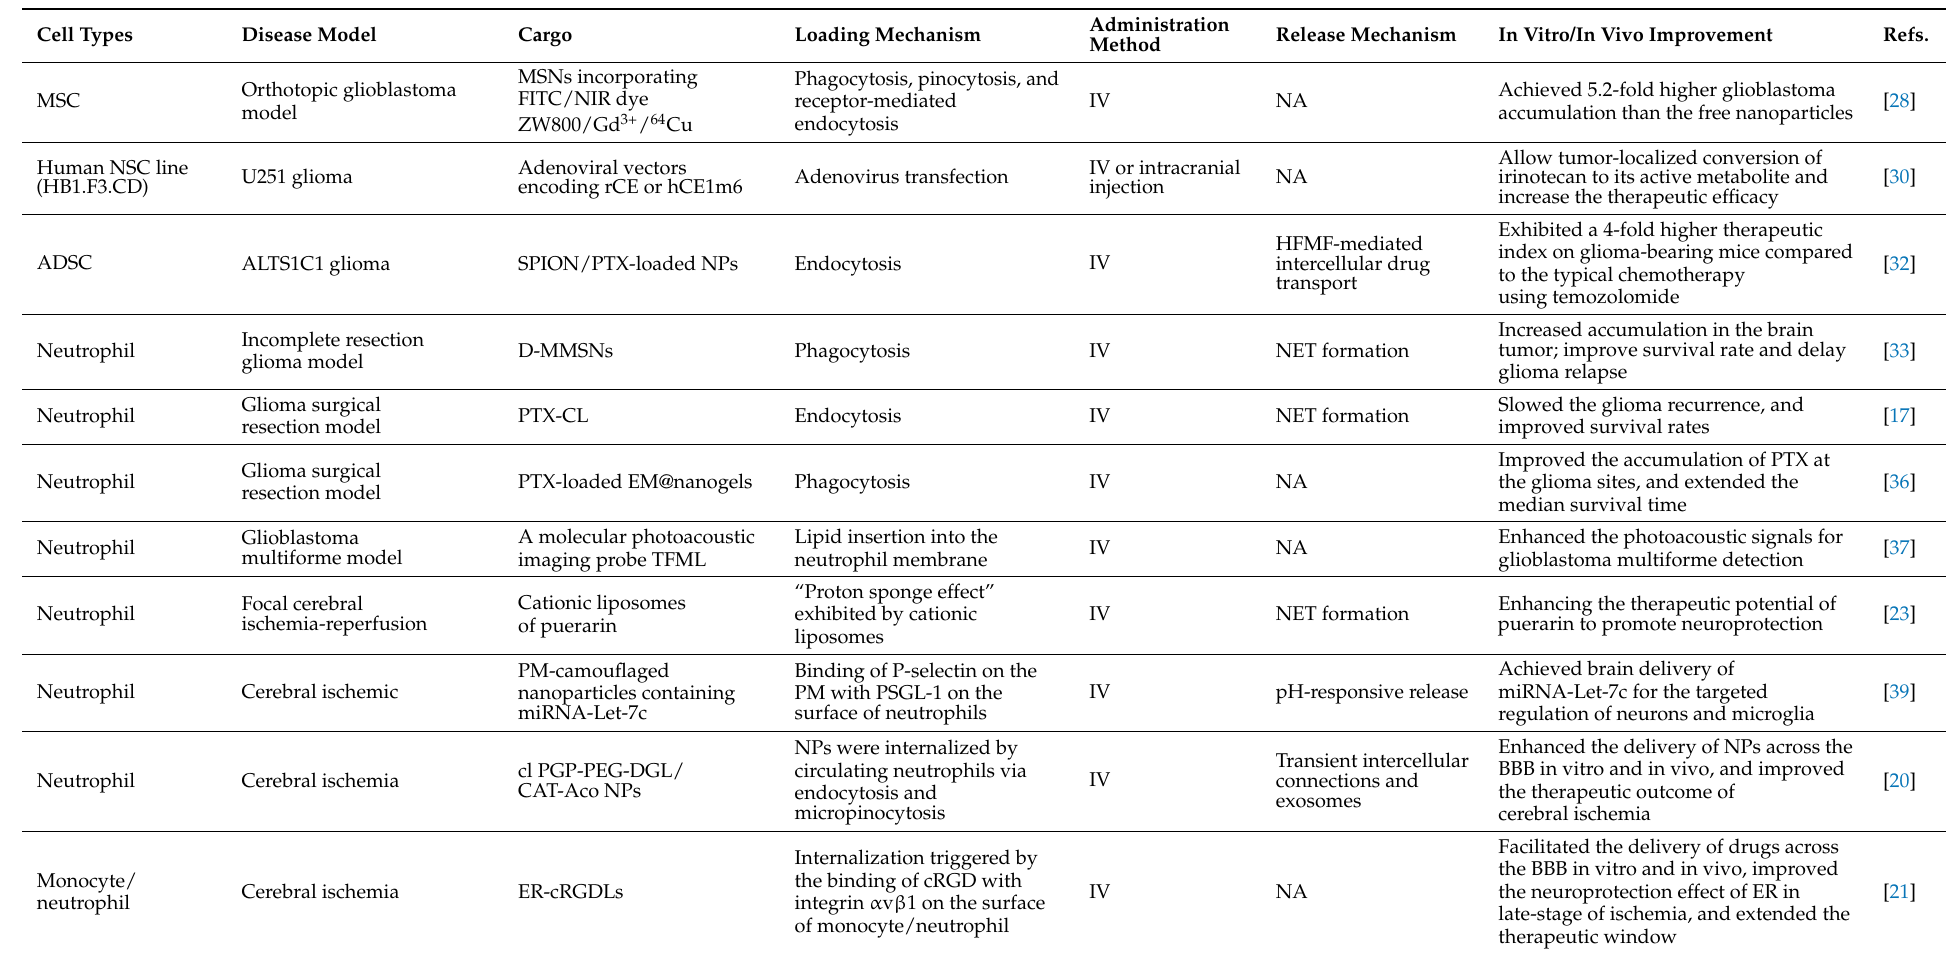
Table 1. Cell-mediated BBB-crossing